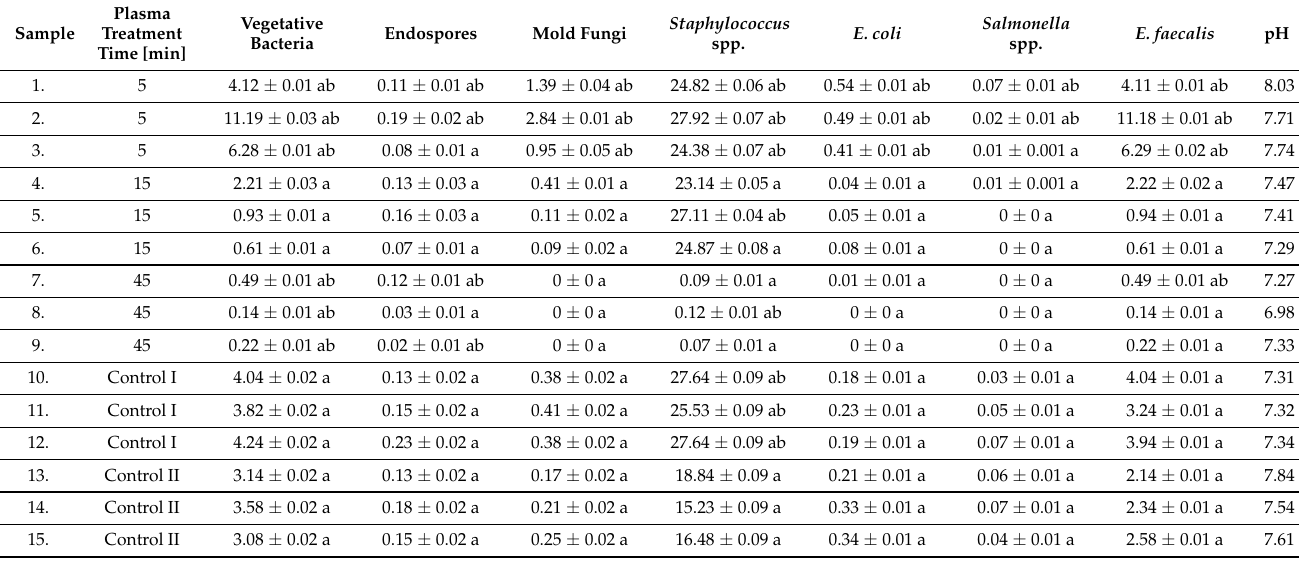
Table 5. Average number of microorganisms (10 6 CFU/g RDF) and average pH of tested samples of raw material subject to plasma process (CFU-Colony-Forming Unit, RDF-Refuse-Derived Fuel).